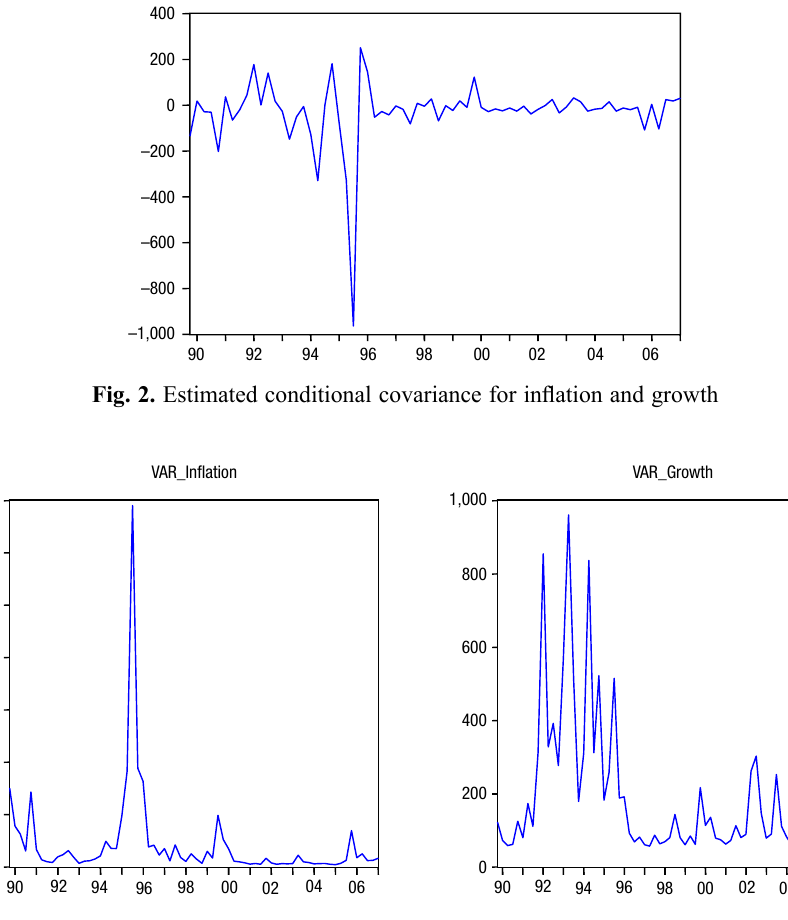
Fig. 3. Estimated conditional variances of inflation and